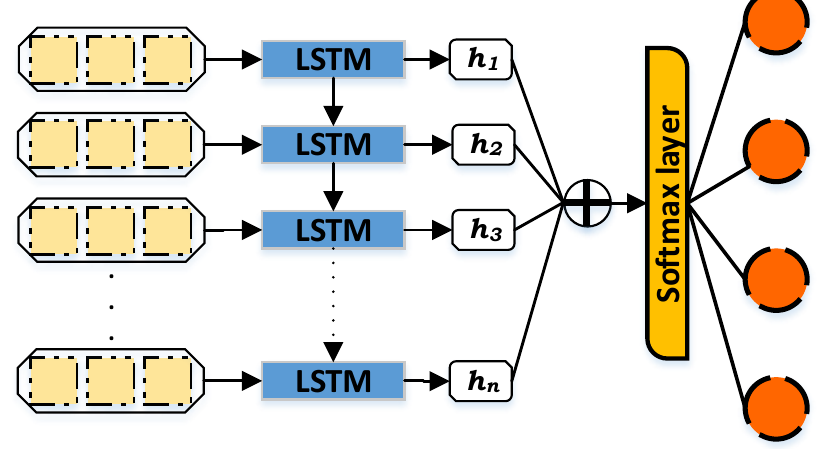
Figure 3. Long Short-Term